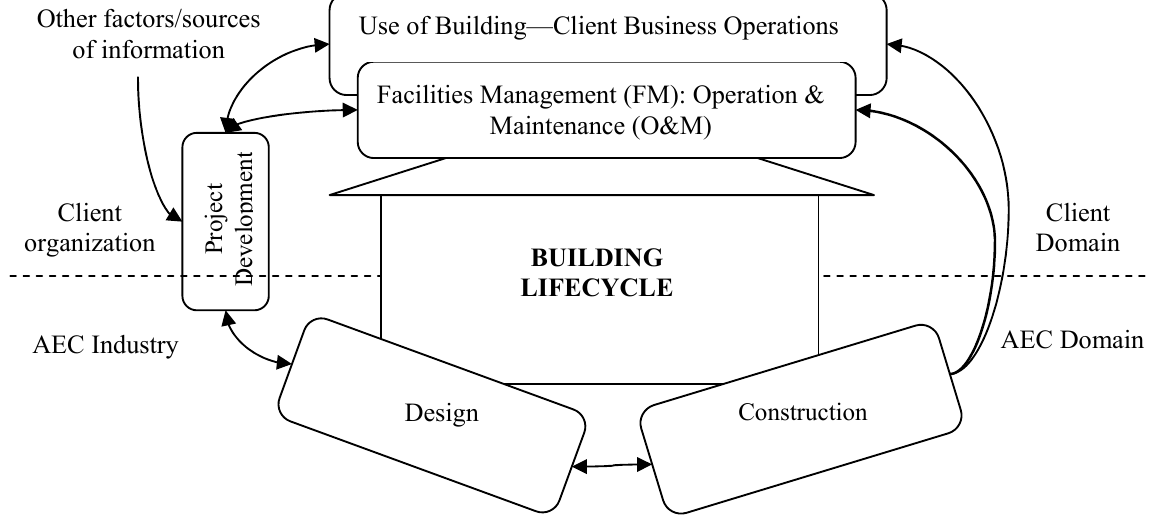
Figure 1. Simplified model of building lifecycle stages and interface between client and Architecture, Engineering and Construction (AEC) industries